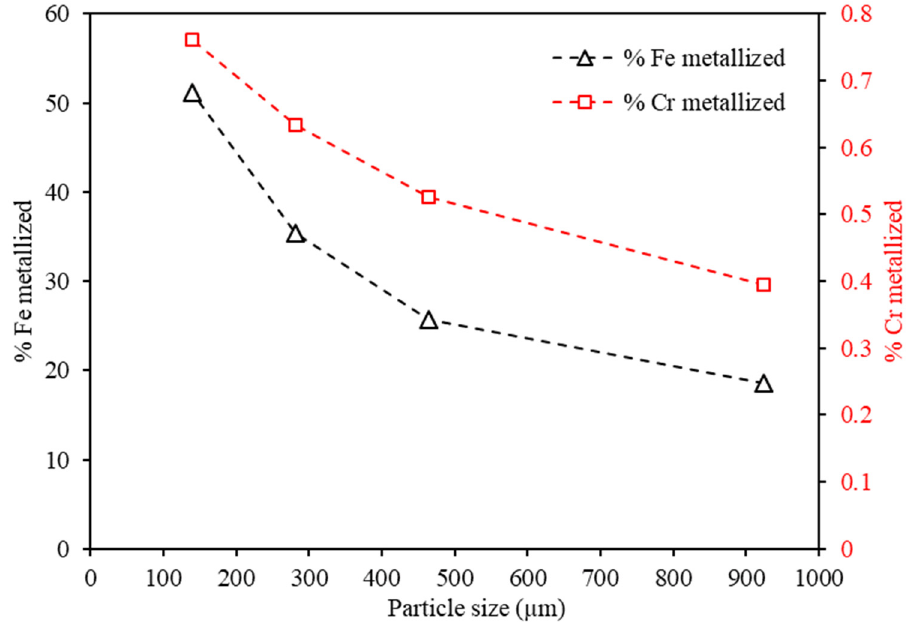
Figure 9. The effect of particle size on Cr and Fe metalization. Thermal treatment was performed at 1100 °C for 30 min.